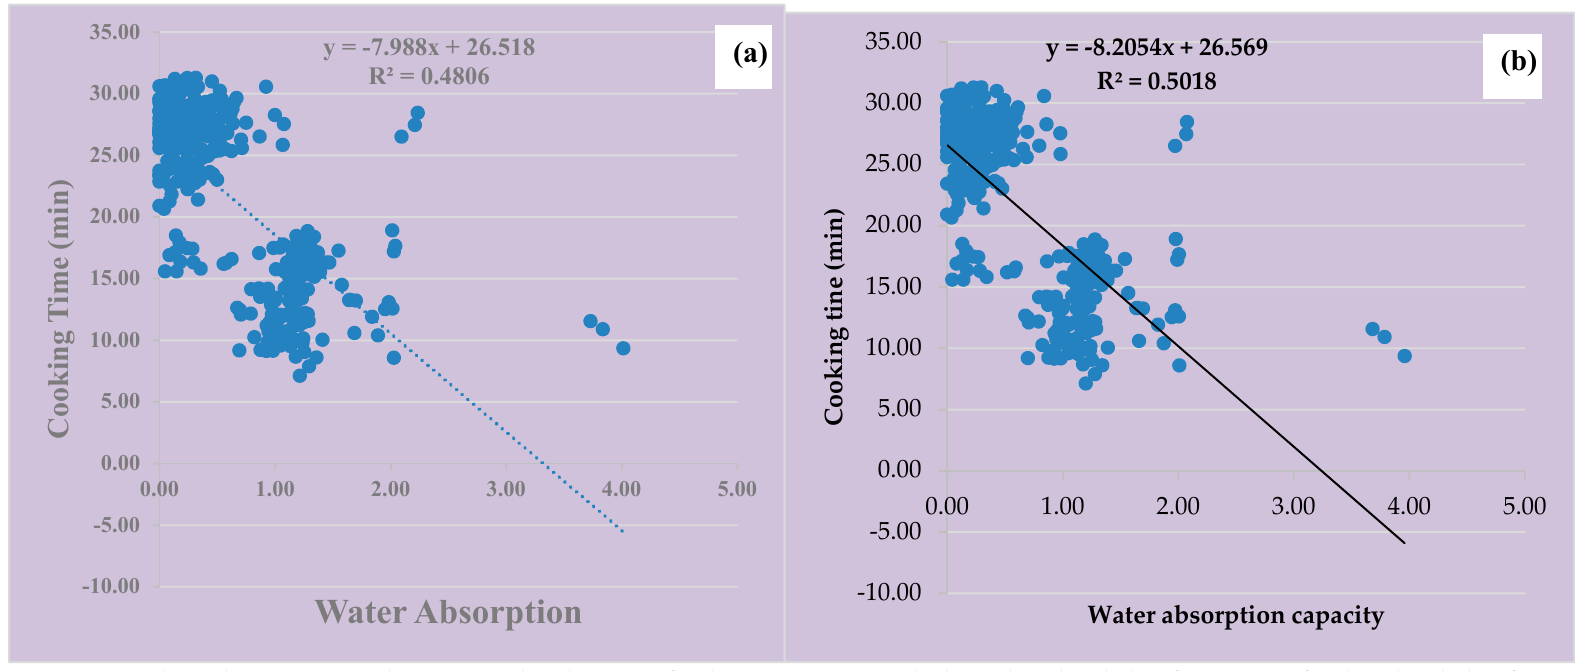
Figure 7. Correlation between water absorption and cooking time for the Vigna species studied. ( a ) Plotted with data from Site A; ( b ) plotted with data from Site B.